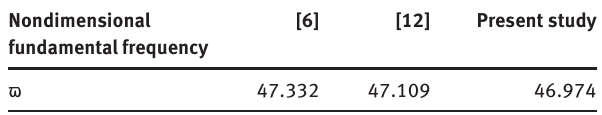
Table 2 Comparison of the present study for a simply supported square spherical shell. cross ply (0 ° /90 ° ) 4